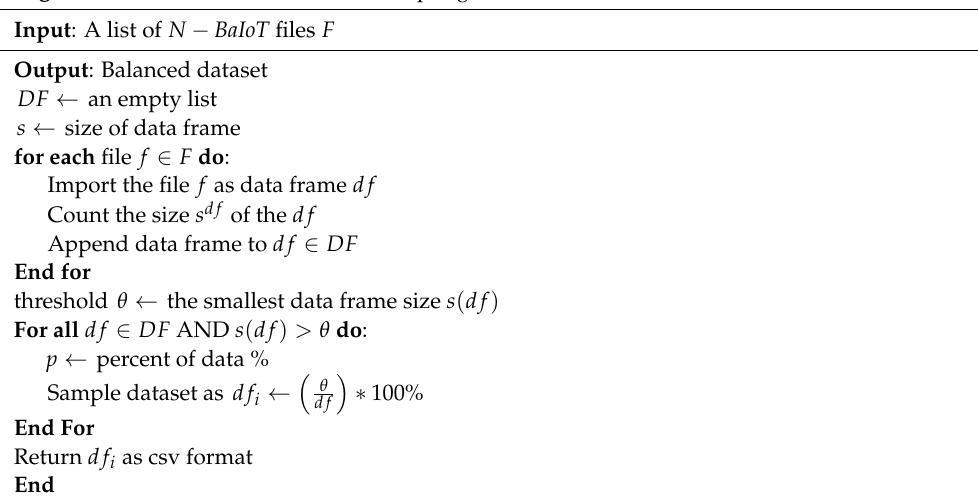
Algorithm 1 Pseudocode of Dataset